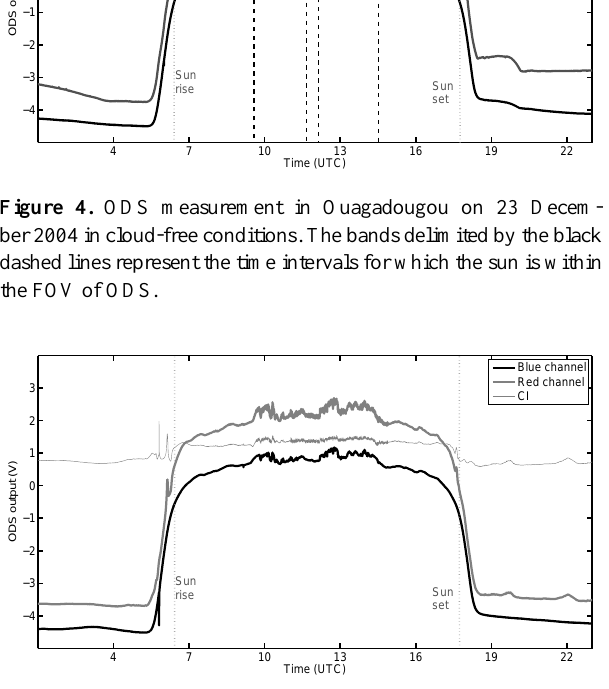
Figure 5. Same as Fig. 4 but on a fully overcast day.